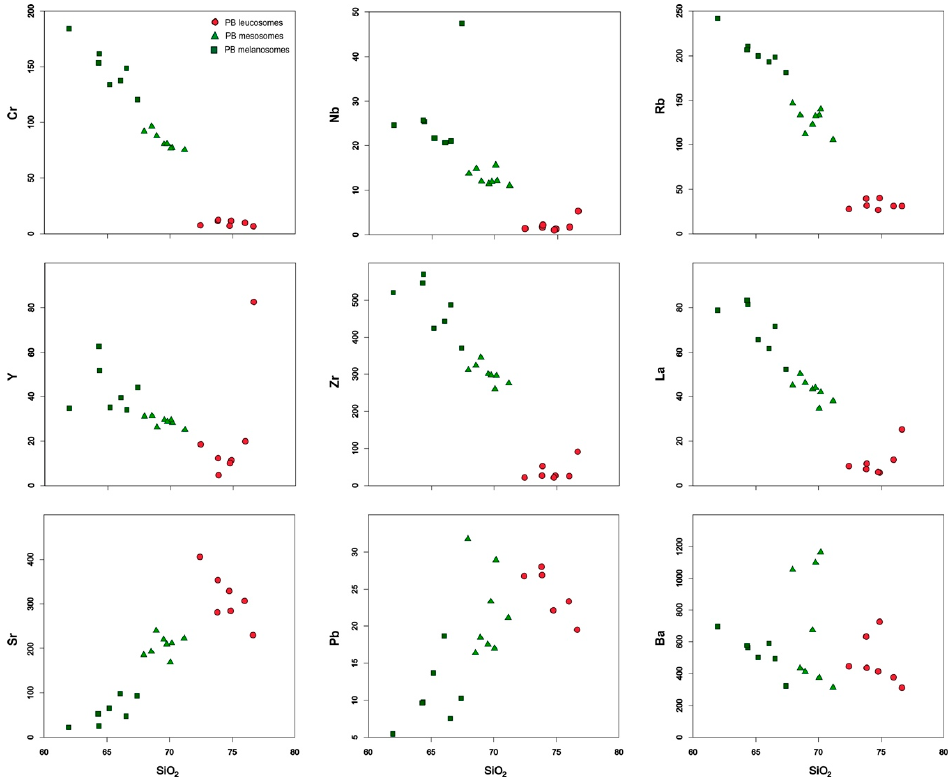
Figure 6. Harker diagrams for selected trace elements (ppm). Geosciences 2020 , 10 , 123